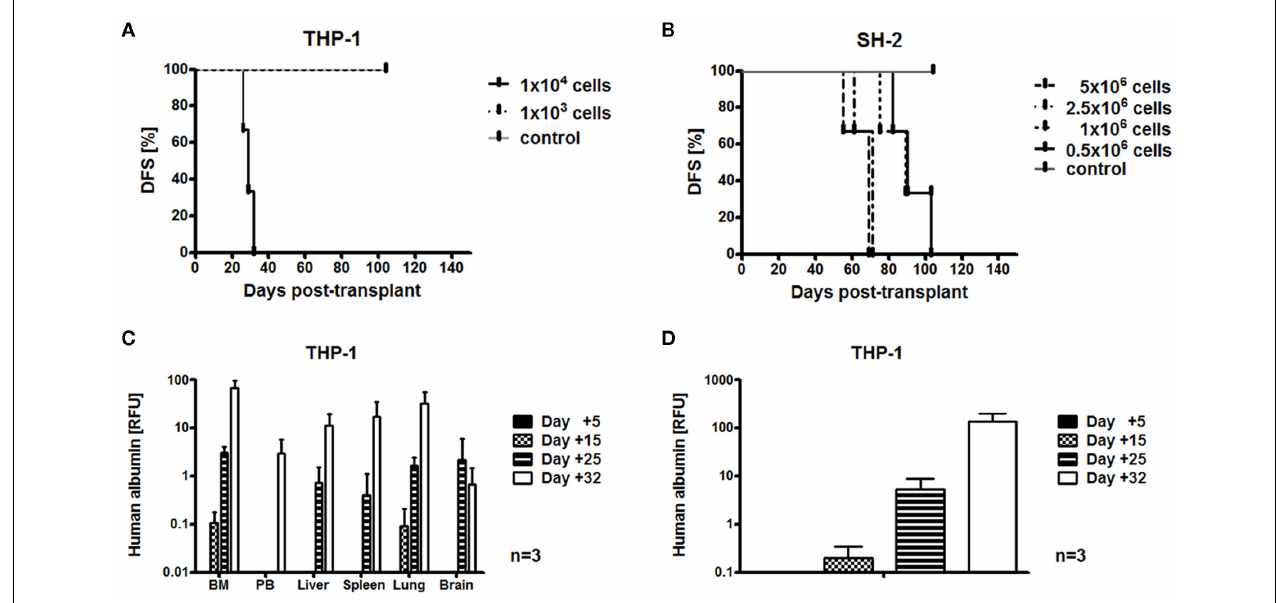
developed disease within 82–103days (B) . PCR-based detection of human albumin showed that most of theTHP-1 engraftment occurred in the bone marrow (BM), but was also detectable at decreasing amounts in lung, spleen, liver peripheral blood (PB), and brain (C) .THP-1 engraftment within bone marrow (BM), peripheral blood (PB), liver, spleen, lung, and brain taken together increased by 665-fold (day + 15, 0.20; day + 32, 132.95) within 17days (D)